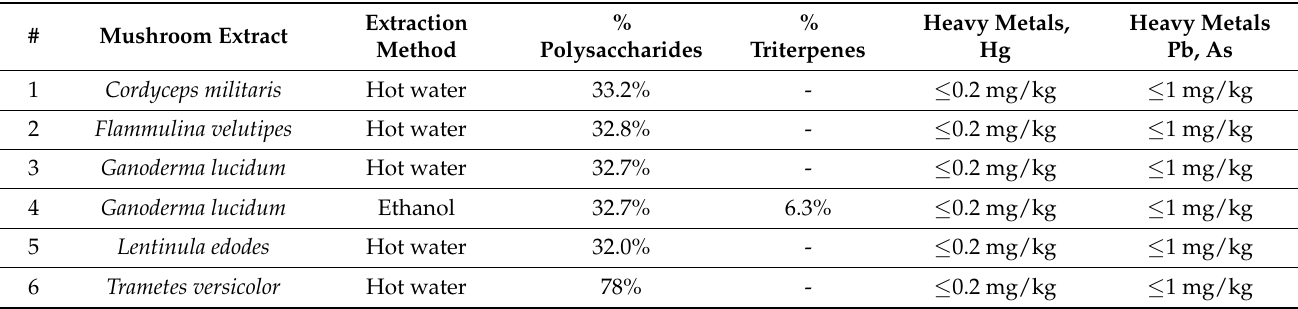
Table 1. The components in mushroom extracts